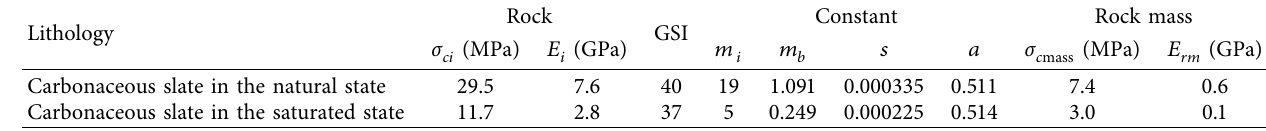
Table 6: Strength of the carbonaceous slate rock mass.